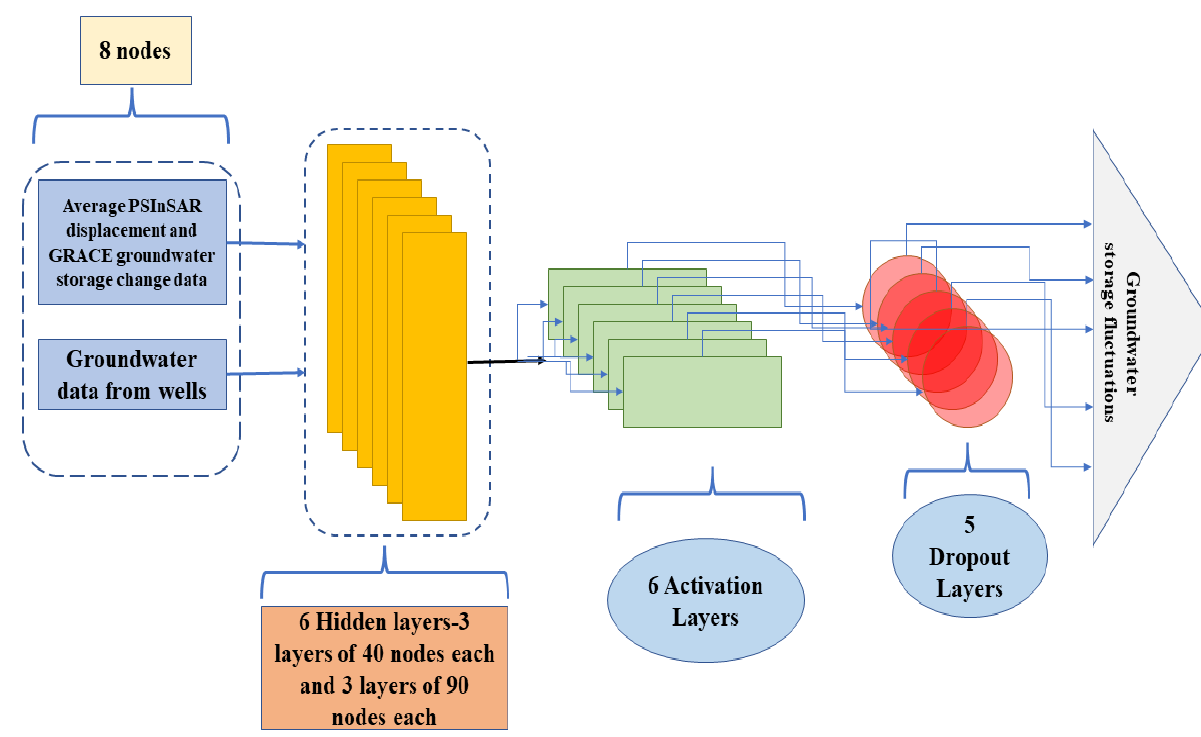
Figure 4. Schematic diagram of the DLMLP model used .